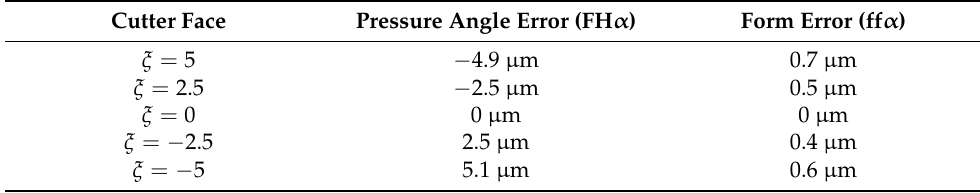
Table 3. Cutter edge profile error of the corrected case corresponding to the cutter faces. Cutter